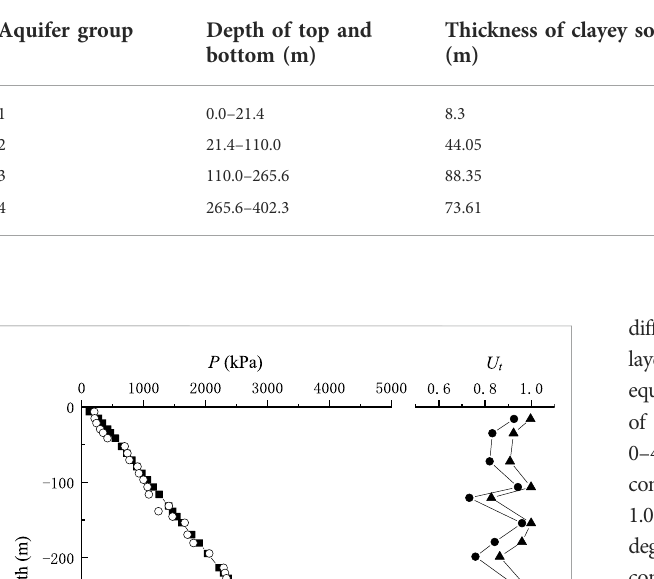
TABLE 4 Aquifer group division and stratigraphic thickness of lithologies.